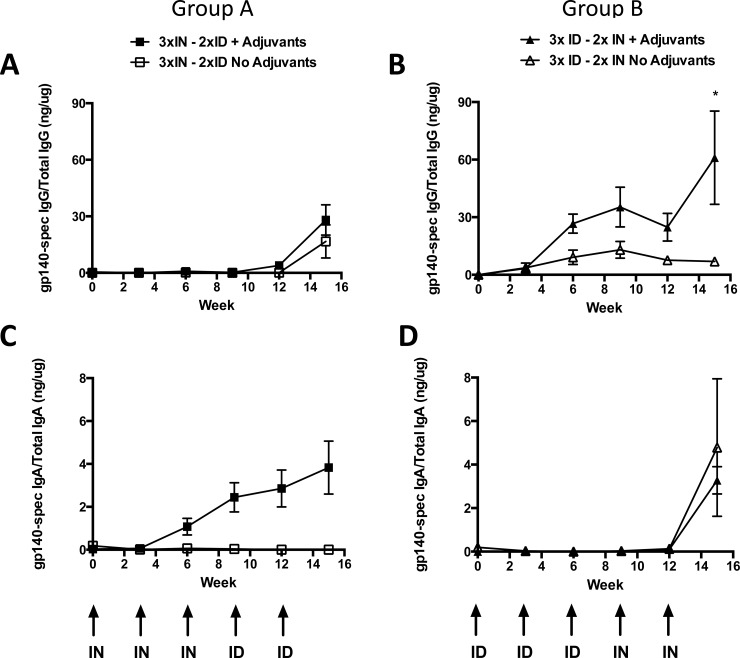
Combinations of R848 and/or GLA-AF administered by each route significantly enhance HIV Env gp140 antigen-specific nasal mucosal immunoglobulin responses.A) Group A (3 × IN + 2 × ID) animals had undetectable antigen-specific nasal IgG until after the first ID vaccination While slightly elevated these responses were essentially indistinguishable from animals that received the unadjuvanted vaccine. B) Group B (3 × ID + 2 × IN) animals demonstrated higher nasal mucosal IgG compared to animals that received the unadjuvanted vaccine (*p = 0.0167; Week 15). C) IN inoculation elicited antigen-specific IgA that was boosted intranasally after ID vaccinations. D) ID vaccinations did not elicit any detectable antigen-specific IgA in the nasal cavity. Subsequent IN inoculation generated low levels of specific IgA.